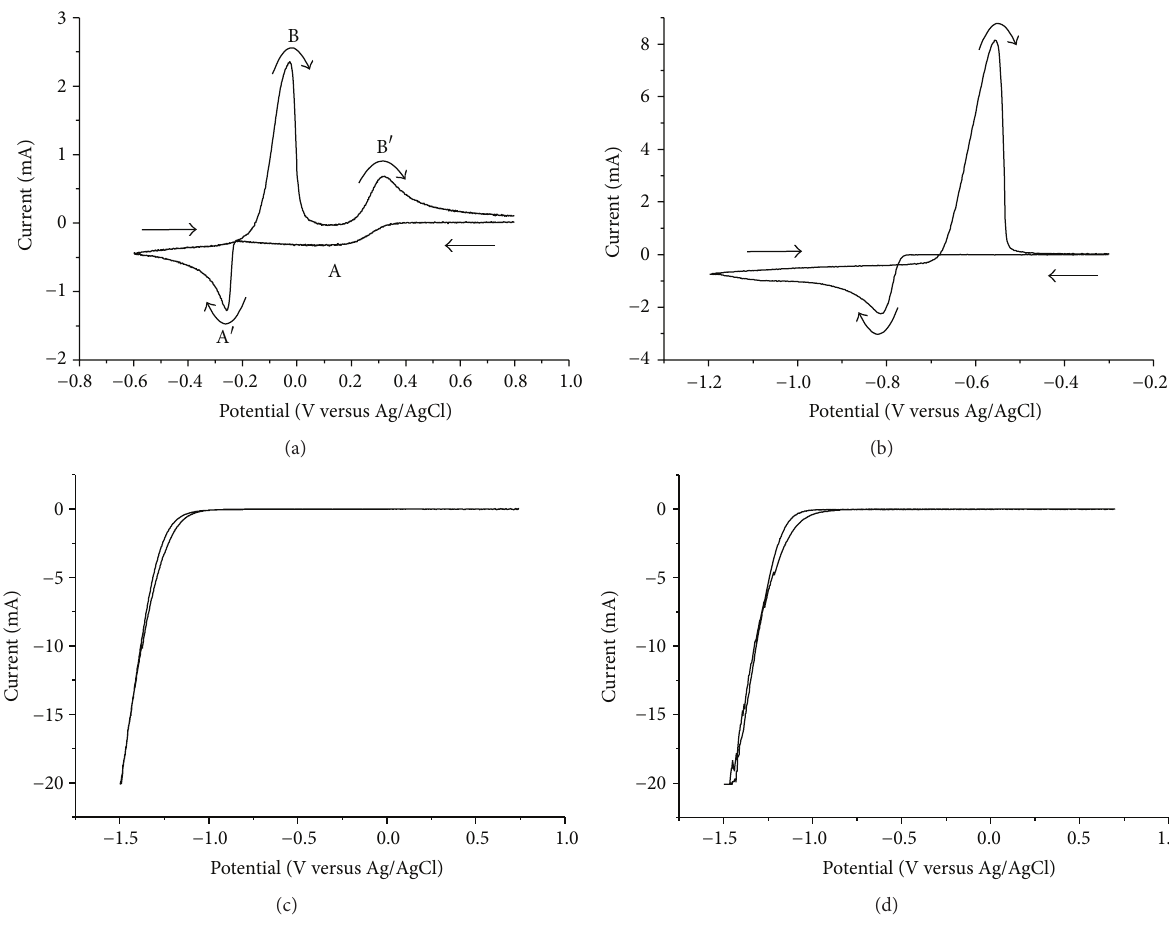
Figure 1: Voltammogram for 0.05 M (a) copper(II), (b) indium(III), and (c) gallium(III) in an electrolyte of 1M HCl (d). The solutions were analyzed using a scan rate of